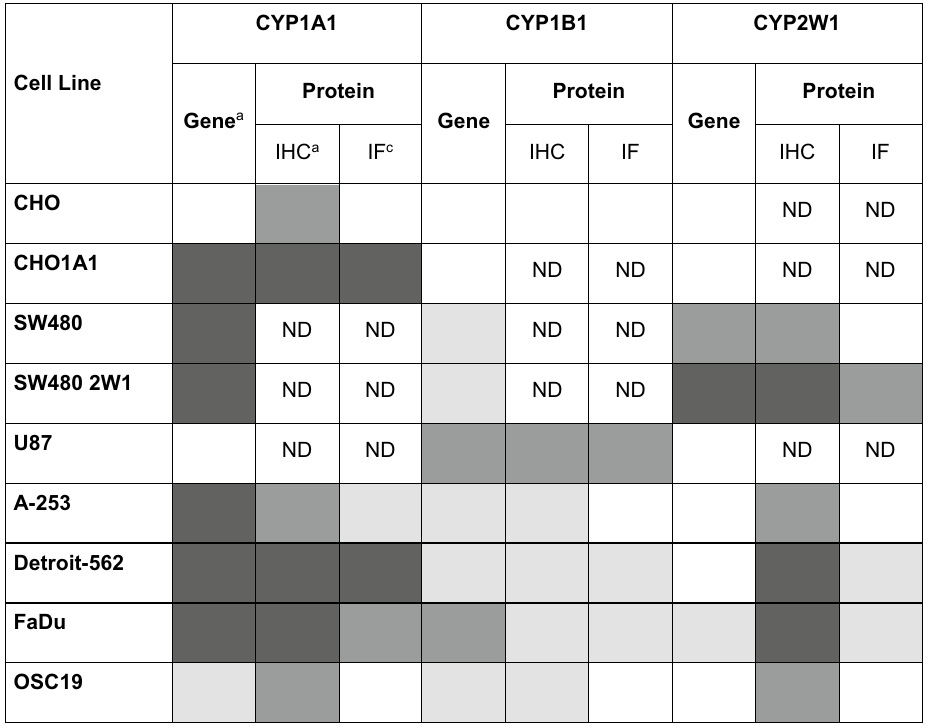
Table 1. Summary of CYP1A1, 1B1 and 2W1 gene and protein expression levels. a RT-PCR expression in Fig. 2A–C, b expression by immunofluorescence in Fig. S2A–C, c expression by immunohistochemistry in Figs. 3 and S3A–C; ND not determined. White—no expression, light gray—low expression, gray—moderate expression, dark gray—high